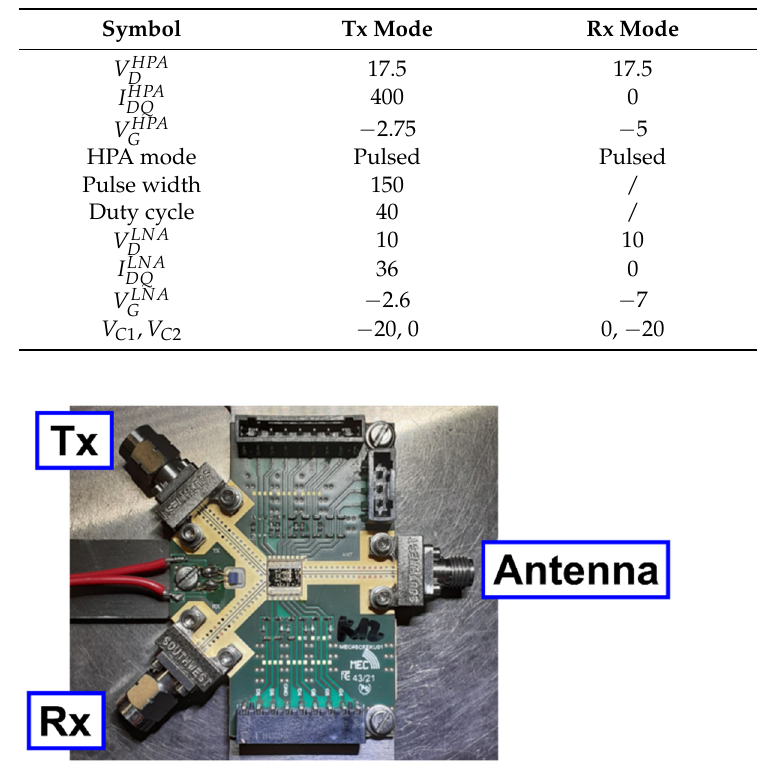
Table 1. SCFE bias requirements in the different modes.